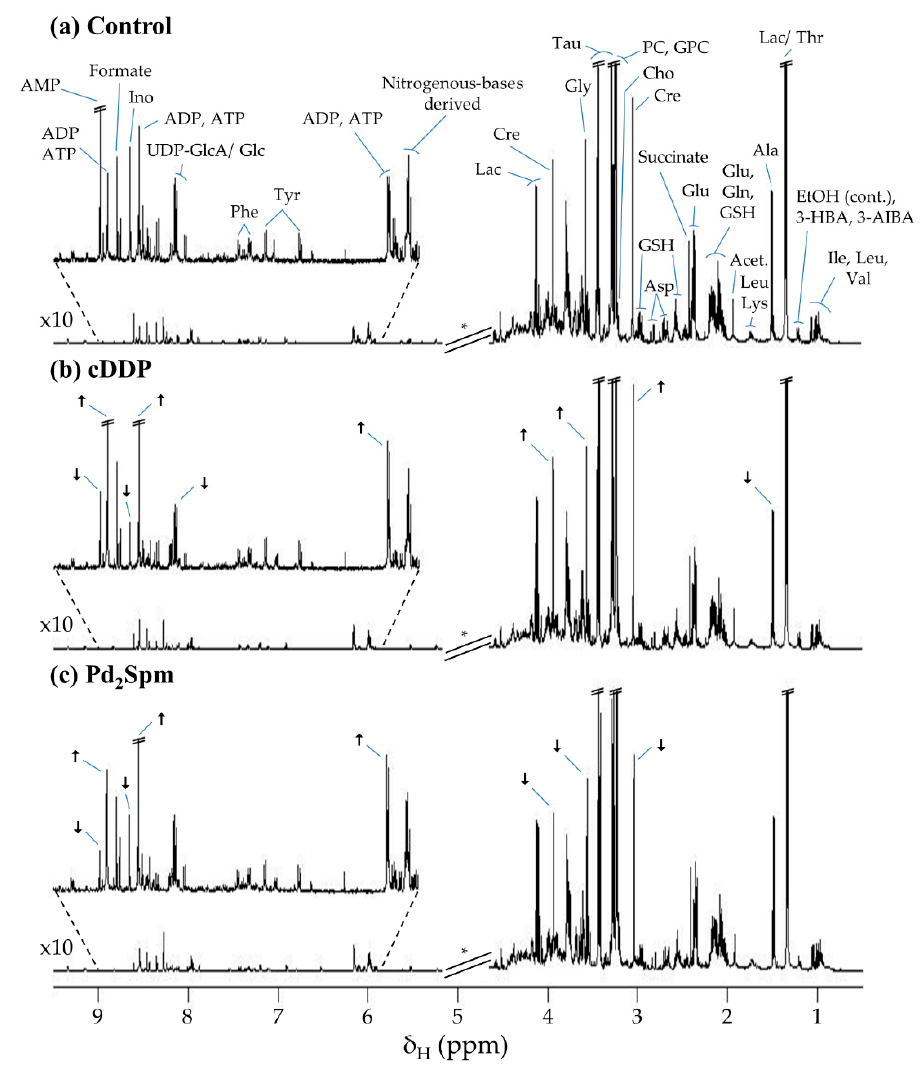
Figure 1. Average 500 MHz 1 H nuclear magnetic resonance (NMR) spectra of aqueous extracts of tumors from MDA-MB-231 cell-derived xenograft (CDX) mouse model after exposure to ( a ) vehicle (phosphate-buffered saline, PBS), ( b ) cDDP, and ( c ) Pd 2 Spm. * Cut-off of water suppression region ( δ 4.60–5.20), not considered in the multivariate analysis. The arrows identify visually apparent metabolic variations between treated groups and controls. Abbreviations: 3-letter code for amino acids; 3-AIBA, 3-aminoisobutyric acid; 3-HBA, 3-hydroxybutyrate; Acet., acetate; ADP, adenosine diphosphate; AMP, adenosine monophosphate; ATP, adenosine triphosphate; Cho, choline; Cre, creatine; EtOH, ethanol (contaminant); GPC, glycerophosphocholine; GSH, glutathione (reduced); Ino, inosine; Lac, lactate; PC, phosphocholine; Tau, taurine; UDP-GlcA/ Glc, uridine diphosphate-